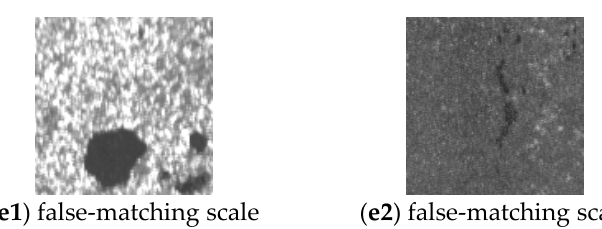
Figure 16. Examples of misclassified defects of cracks, scratches, indentations, pits, and scales.